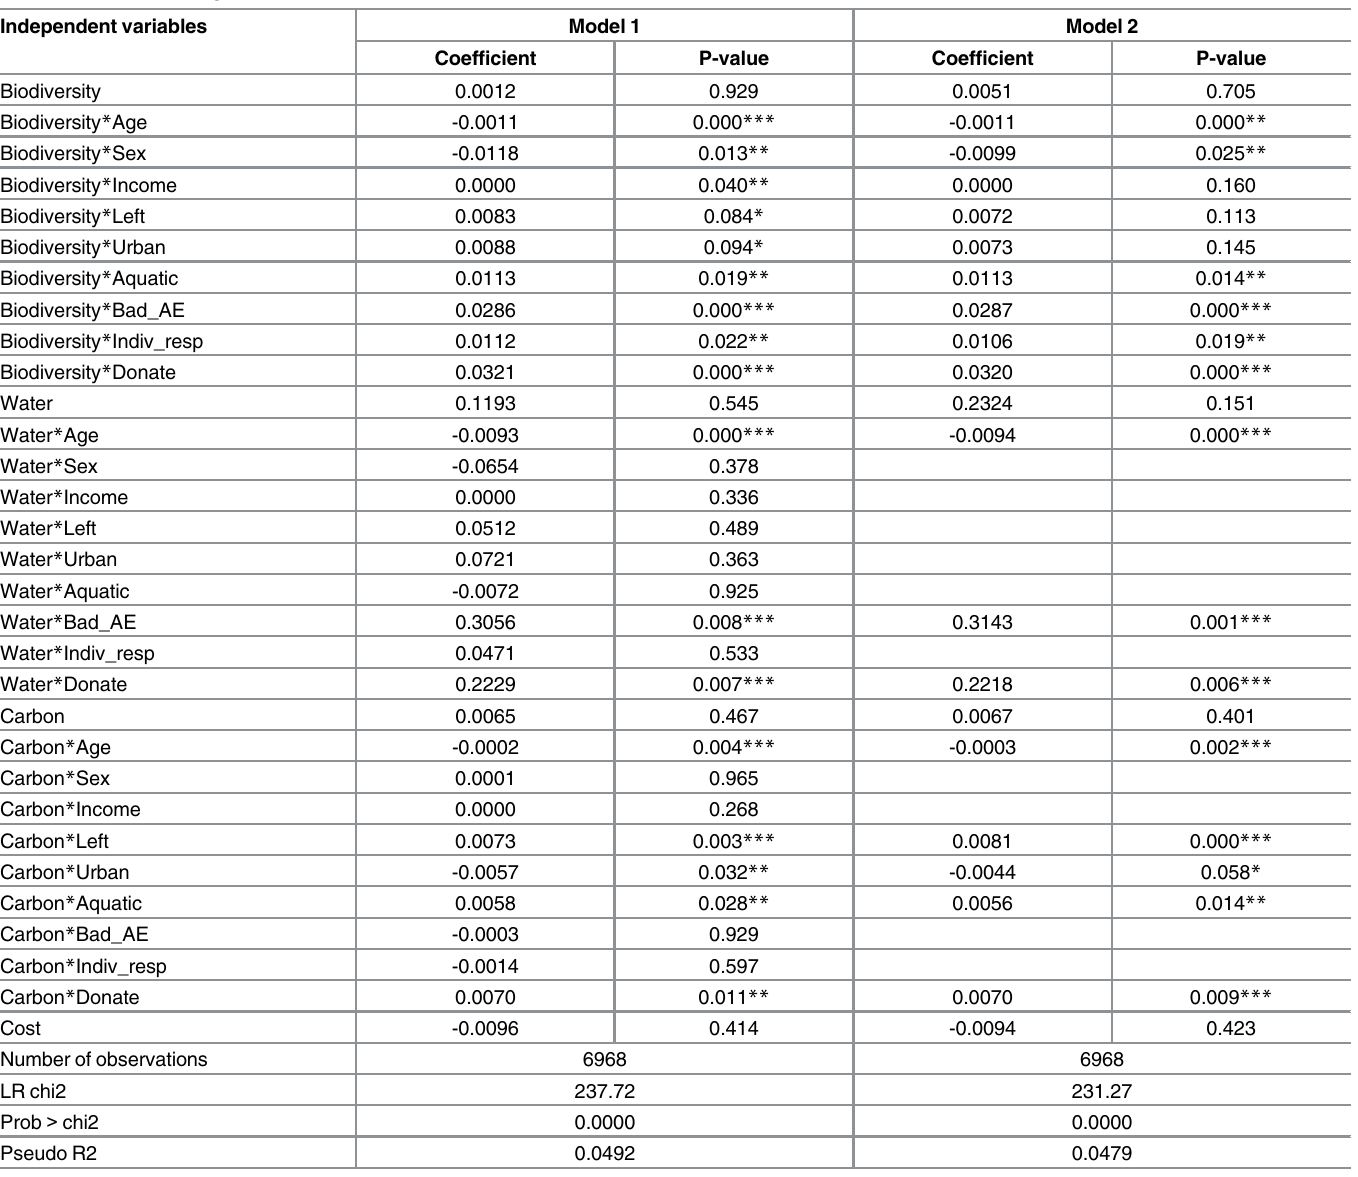
Table 3. Conditional logit